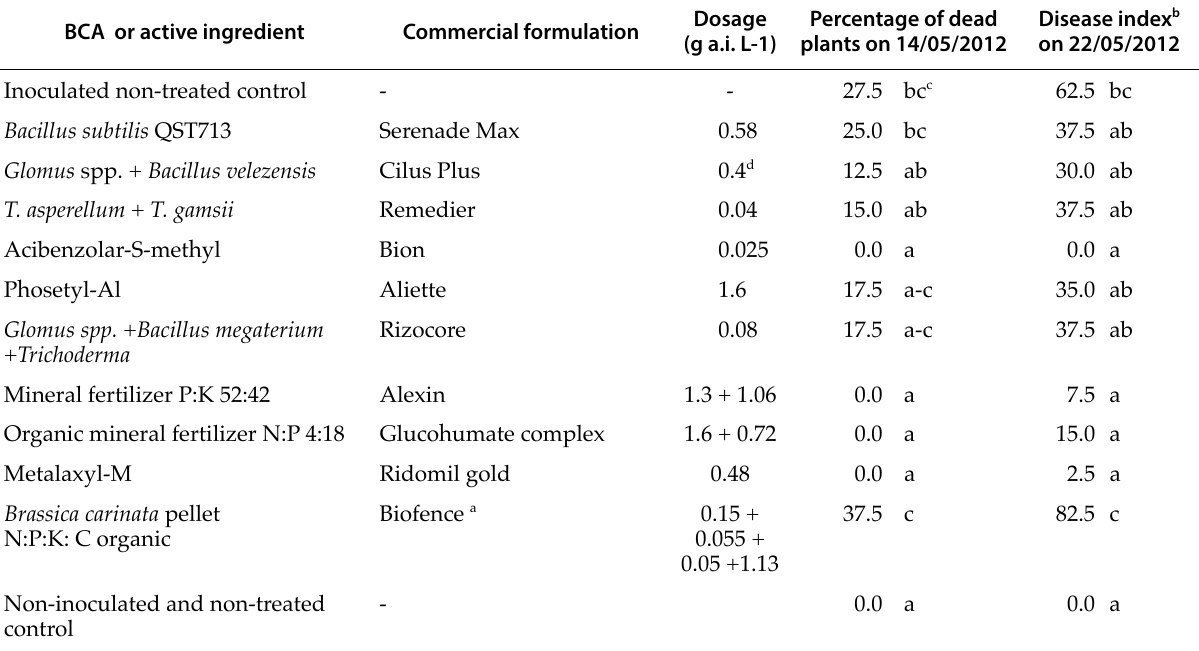
Table 3. Trial 1. Mean proportions of dead plants, mean disease indices (0‒100) and mean total plant fresh weights, for tomato plants receiving different